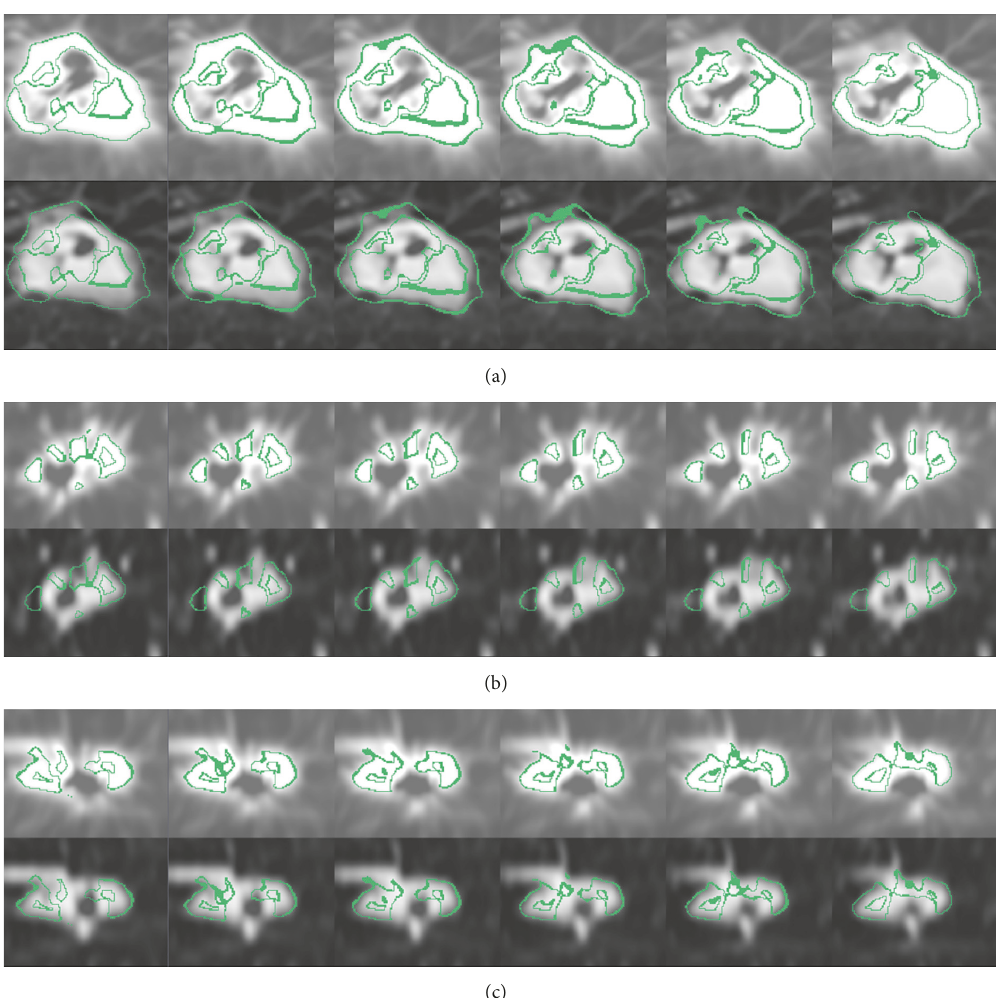
Figure 4: Volume change tracker for Figure 3 showing that lesion shrinkage changes with six successive slices in the three planes. The regions around the green lines show changes in warped moving and fixed images. (a), (b), and (c) Lesion in the axial, sagittal, and coronal planes. The above row shows the lesion in warped moving images, while the below row shows the lesion in fixed images. Clear shrinkage of the lesion is noted in the fixed image (0.65%) when compared with that in the warped moving